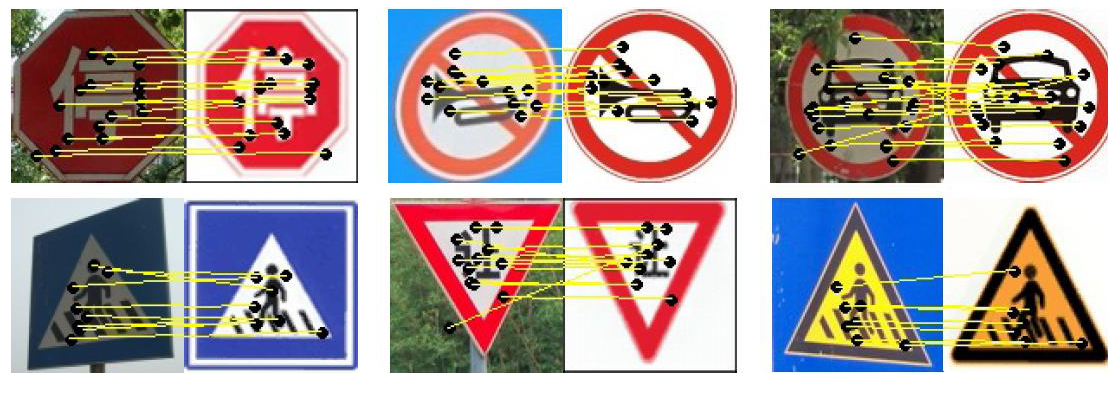
Figure 10. SURF feature matching. The number of match points is 16, 11, 24, 7, 12, 7 according to